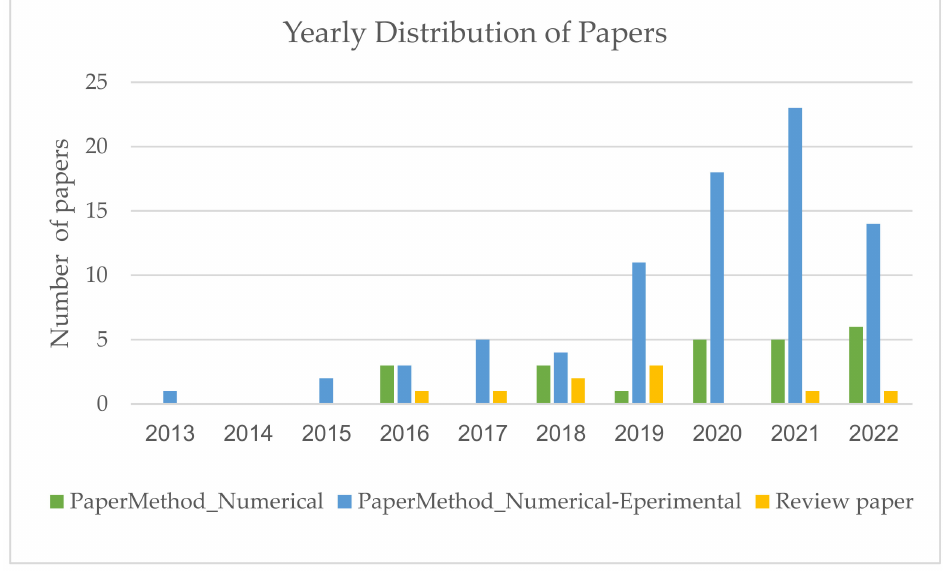
Figure 2. Paper classification